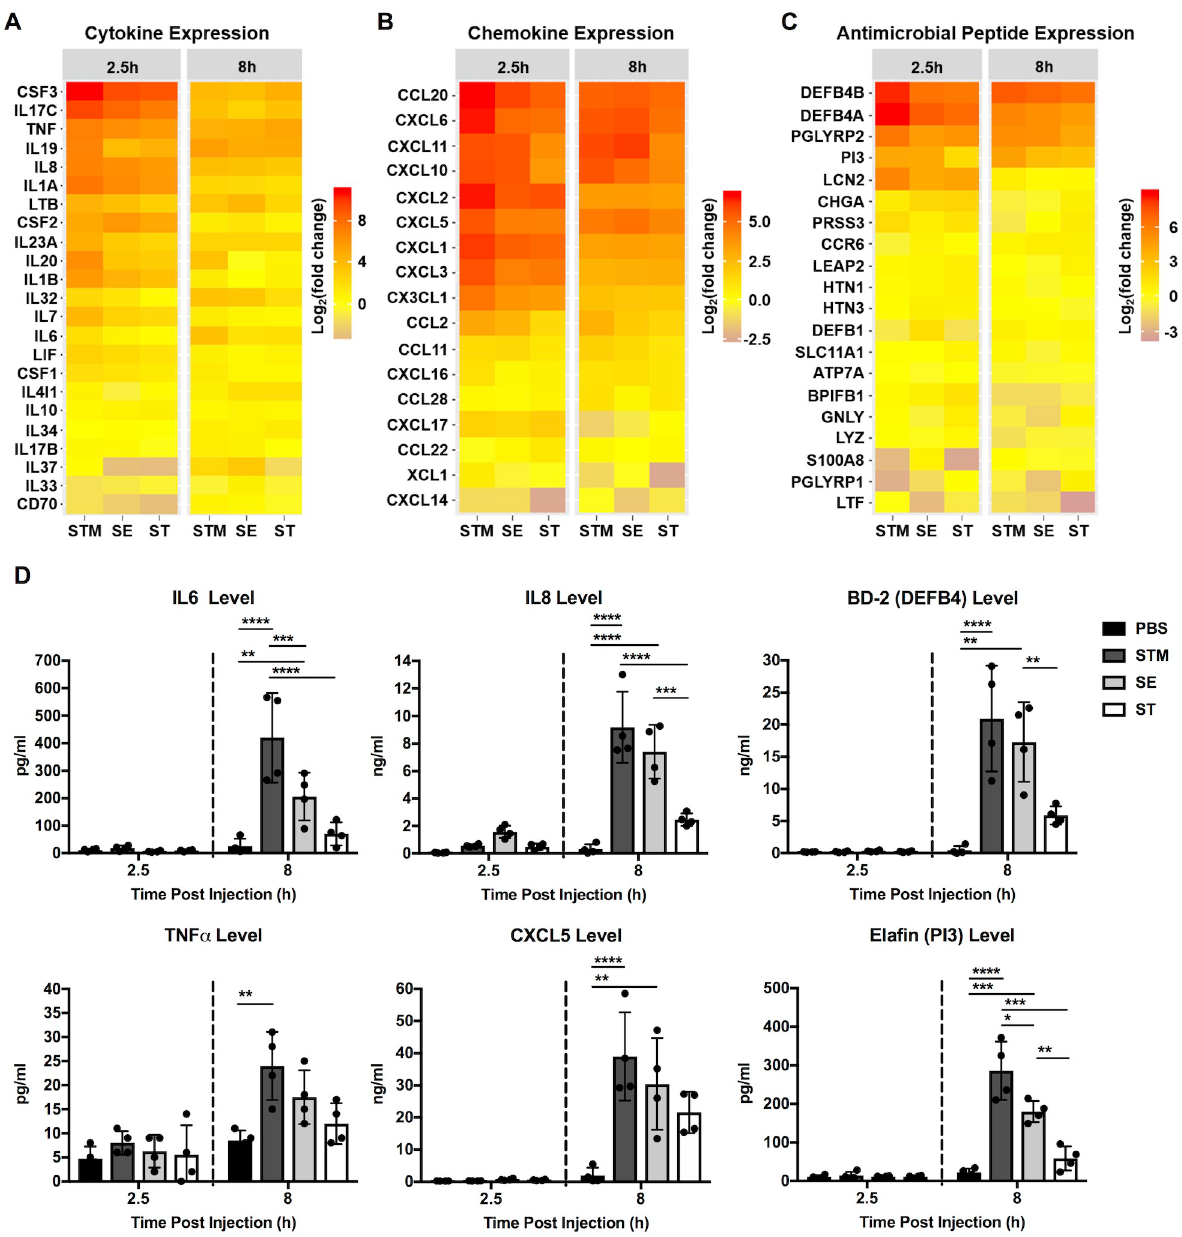
Fig 4. Differential gene expression and secretion of immune modulators by HIOs in response to infection. (A-C) Gene expression of Cytokine (A), Chemokine (B) and Antimicrobial peptide (C) are presented as log 2 fold change relative to PBS at 2.5h and 8h post infection. (D) Cytokine, chemokine and antimicrobial peptide levels measured from HIO supernatant at 2.5h and 8h post infection via ELISA. n = 4 biological replicates. Error bars represent +/-SD. Significance calculated by two-way ANOVA. P values < 0.05 were considered significant and designated by: � < 0.05, �� < 0.01, ��� < 0.001 and ���� <